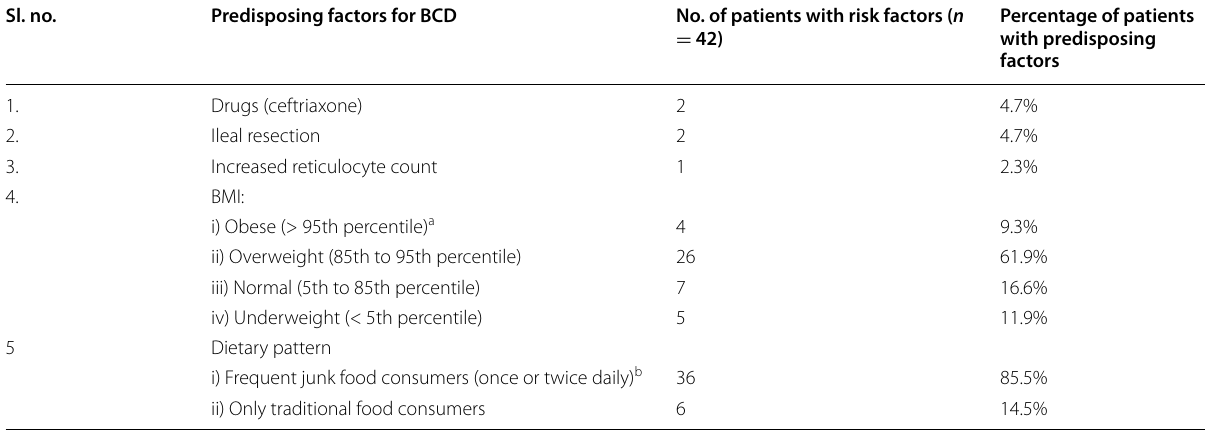
a Based on BMI for age-matched growth charts b Junk food includes chocolates, biscuits, puffed corn (e.g., kurkure), potato chips, deep-fried food, momos, noodles, fried rice, and local savory food like chaat, etc.